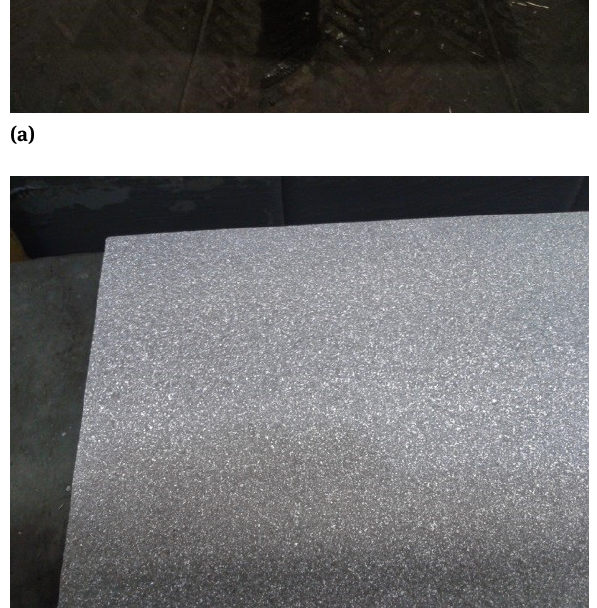
shown in Figure 1 (for the reference point for ϵ = 0, the val- uesof σ B forthecastpreformaretaken).Analysisofthede- pendencies on the graph allows us to conclude that, with an increase in the degree of deformation, the values of the temporary fracture resistance ( σ B ) for all investigated al- loys increase and at ϵ t = 96.8% reach values of the